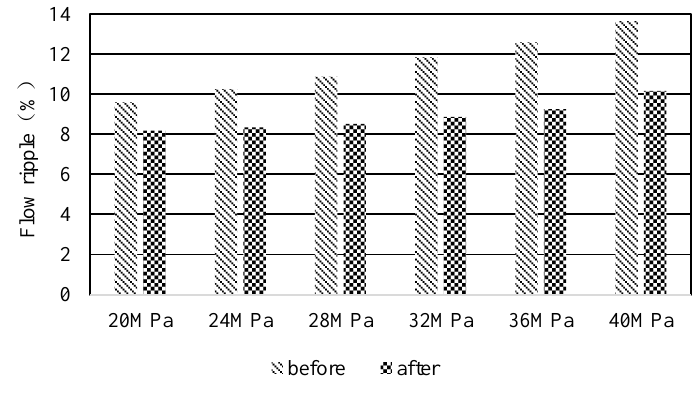
Figure 9. Comparison of flow ripple.